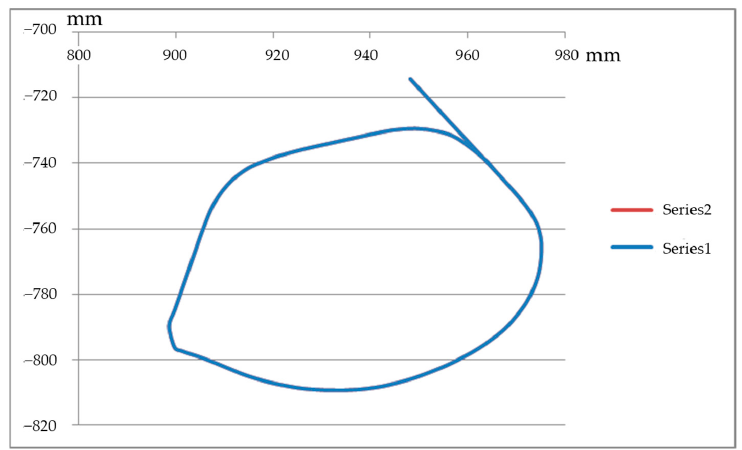
Figure 26. Trajectory sample.